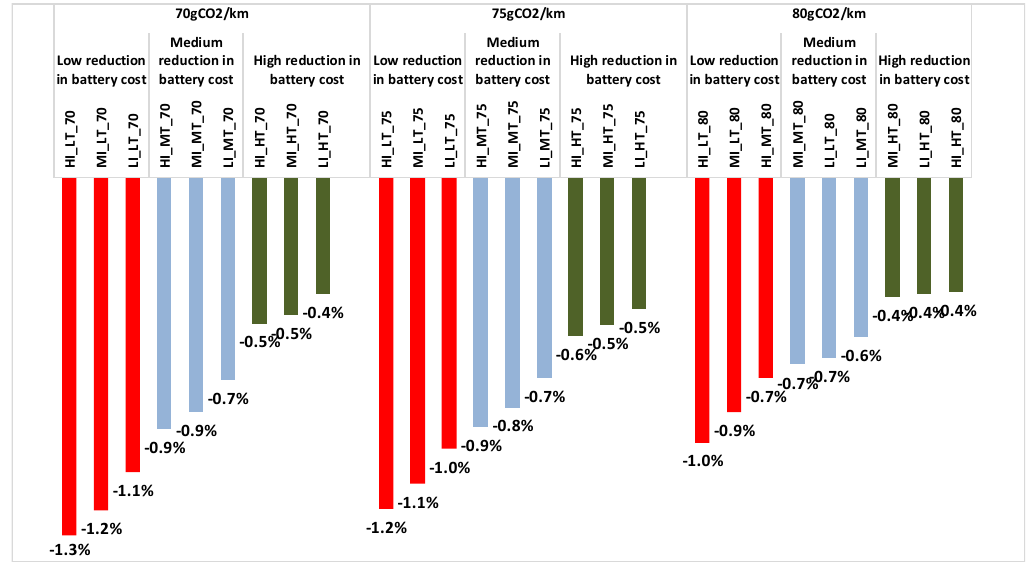
Figure 9. Change of passenger car transport activity, relative to the BAU, in the EU in 2030.